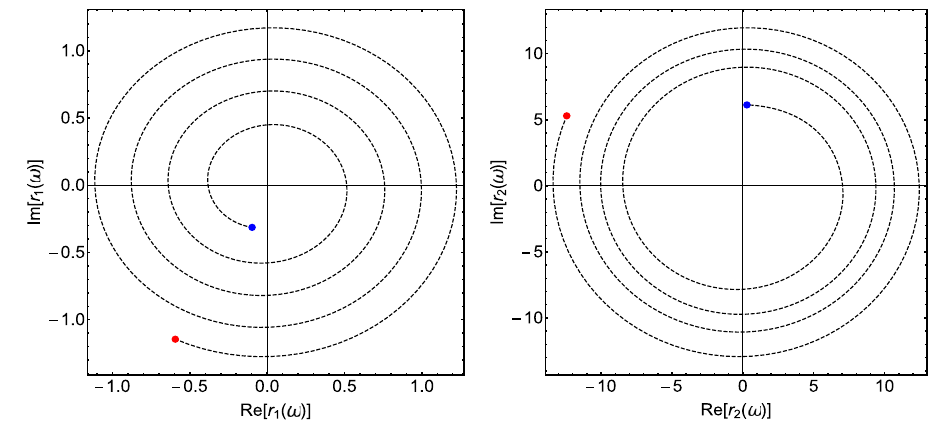
Fig. 4 Path of the first two residues r n (ω) as q varies in the range 0 ≤ q ≤ 0 . 999. The red and blue points correspond to q = 0 and q = 0 . 999, respectively. We set the frequency ω M = 3 .